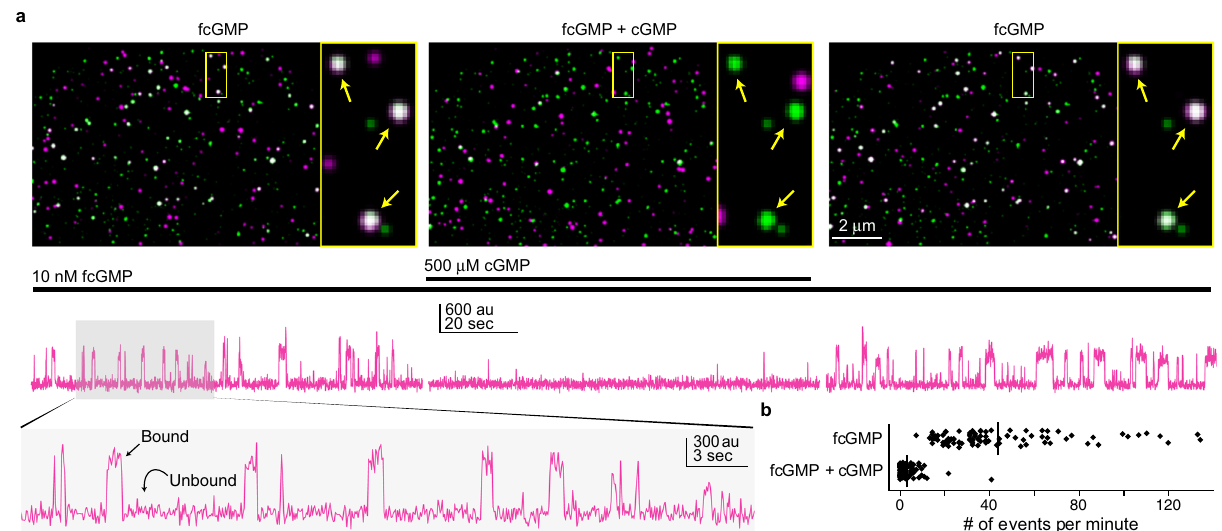
Fig. 2 Single-molecule imaging of fcGMP binding to GFP-TAX-4 in cell-derived nanovesicles. a Time-averaged fl uorescence in arbitrary units (au) for GFP (green) overlaid with fcGMP (magenta). Colocalized GFP and fcGMP signals appear white. From left to right depicts sequential epochs for the same fi eld of view showing binding in 10 nM fcGMP, block of speci fi c binding by coapplication with an excess of 500 μ M non- fl uorescent cGMP, and recovery upon removal of cGMP. The yellow box is expanded to the right of each image and arrows indicate locations exhibiting speci fi c fcGMP binding to GFP- TAX-4. Below each image is time series for fcGMP fl uorescence at a single colocalized spot during each of the epochs in the corresponding images above. Transient increases in fl uorescence re fl ect individual fcGMP binding events in the vesicle layer at the optical surface. The shaded region is expanded below. Results were similar for fi ve separate experiments. b The frequency of binding events in 10 nM fcGMP is greatly diminished in the presence of 500 μ M competing non- fl uorescent cGMP. Source data are provided as a Source Data fi le.